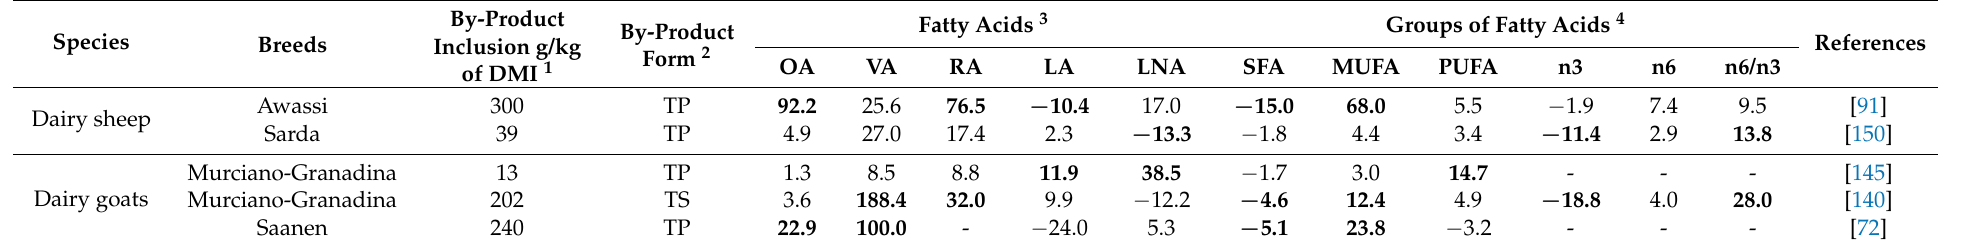
Bold values indicate significant differences ( P <0.05) compared to the control group; 1 DMI = dry matter intake; 2 TS = tomato silage; TP = tomato pomace; 3 OA = oleic acid (cis-9 C18:1); VA = vaccenic acid (trans-11 C18:1); RA = rumenic acid (cis-9,trans-11 CLA); LA = linoleic acid (cis-9,cis-12 C18:2); LNA = alpha linolenic acid (cis-9, cis-12, cis-15